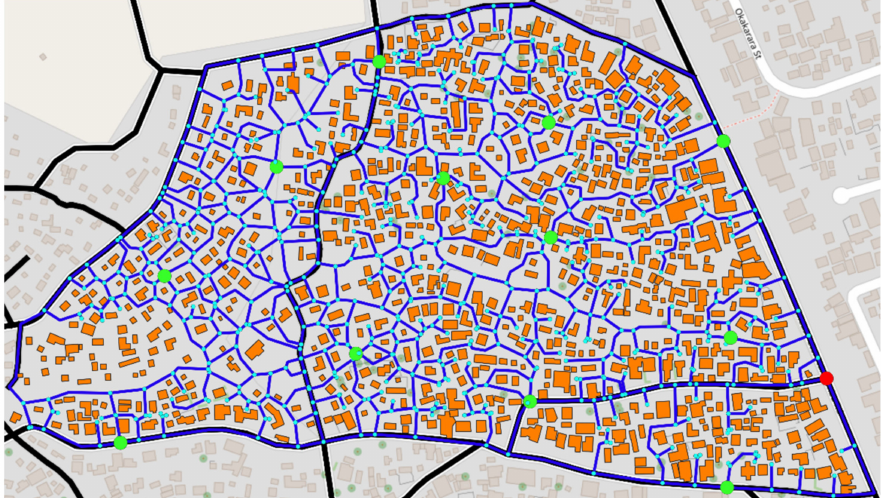
Figure 6. Result of optimal water point-locations (green) in the maximum possible WDS (pipes: blue, nodes: cyan) in the upgrading-area (basemap and buildings/polygons: